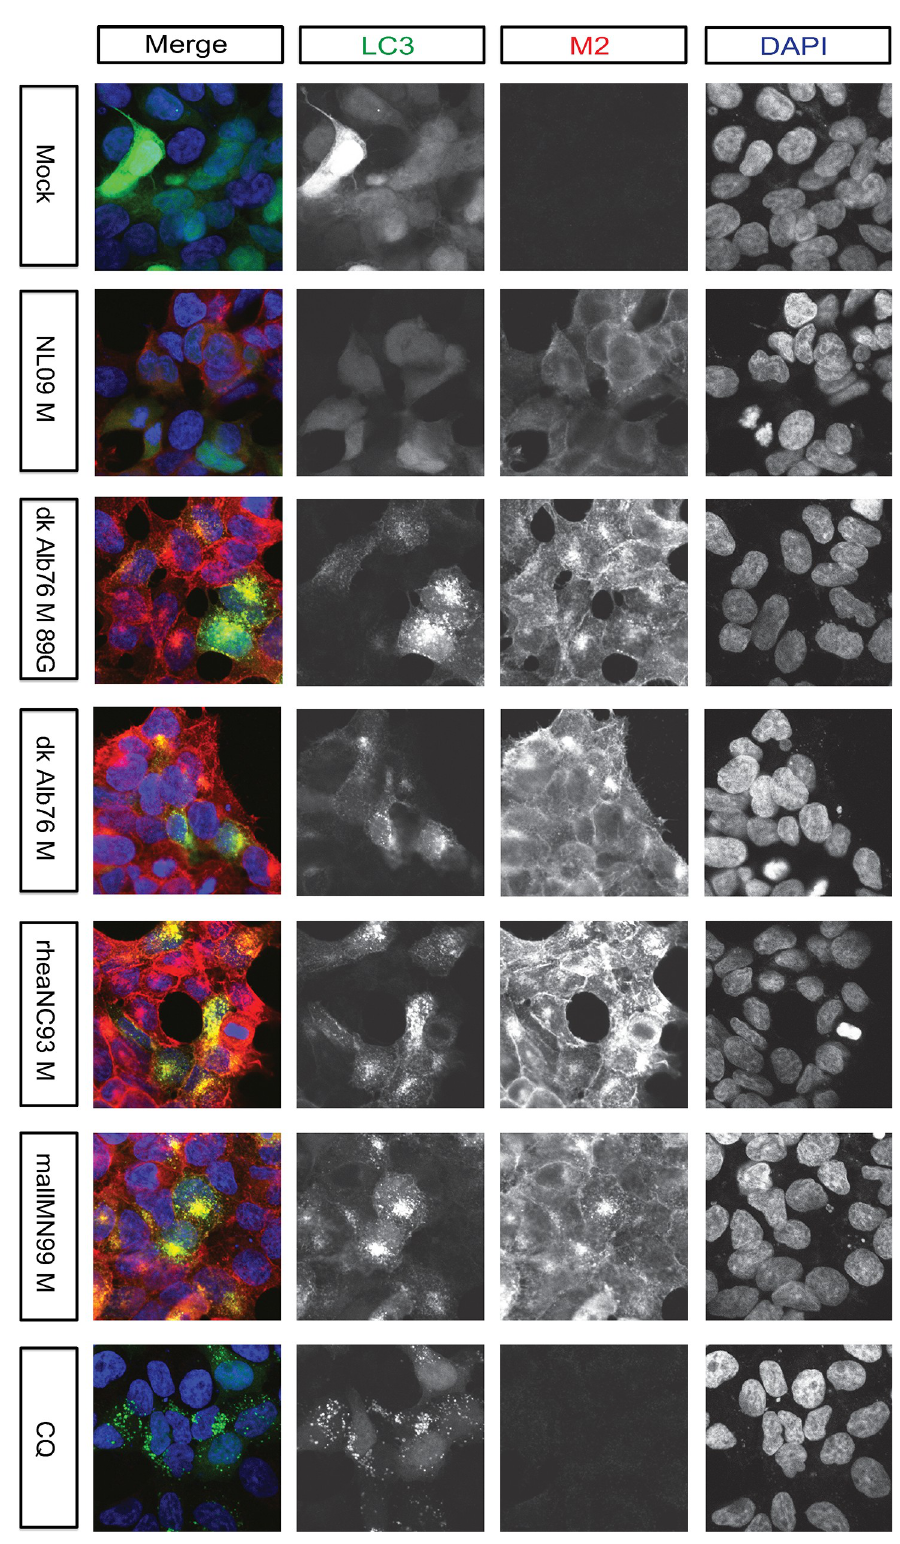
Fig 9. Visualization of LC3 and M2 co-localization. 293T cells were transduced with GFP-LC3 protein and inoculated 24 h later with the indicated IAVs, encoding avian or human-derived M segments, at a MOI of 5